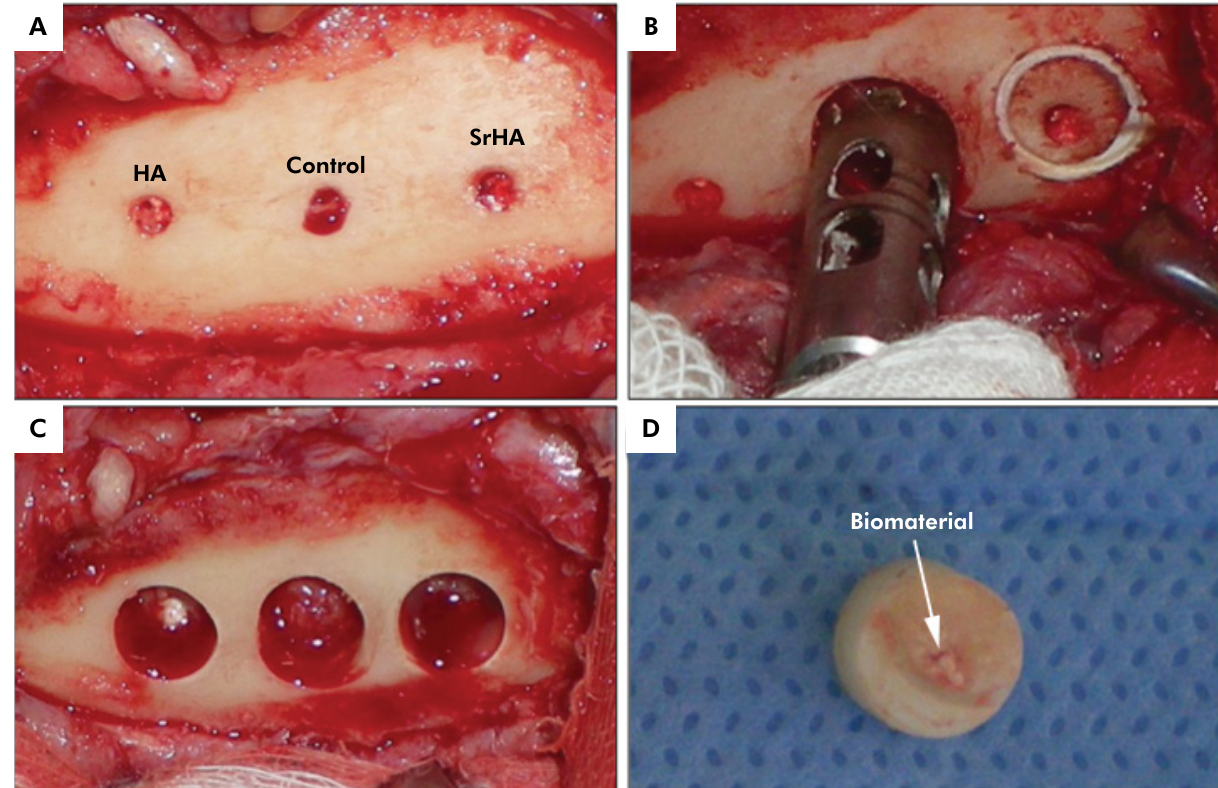
Figure 1. (A) Sheep tibia region of biomaterial placement; (B) trephine bur (Ø 6 mm) used to collect samples from the tibia; (C) sheep tibia after bone block removal for histological evaluation; (D) bone block containing biomaterial microspheres obtained after 30 days of implantation. This technique allows for the maintenance of live animals after the